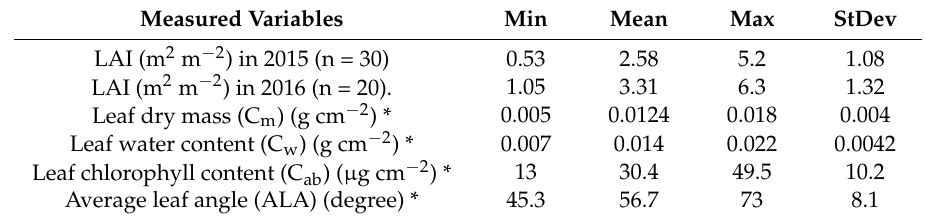
Table 1. Summary statistics of the field measured leaf area index (LAI) and other variables from the two field campaigns in Schiermonnikoog island, The